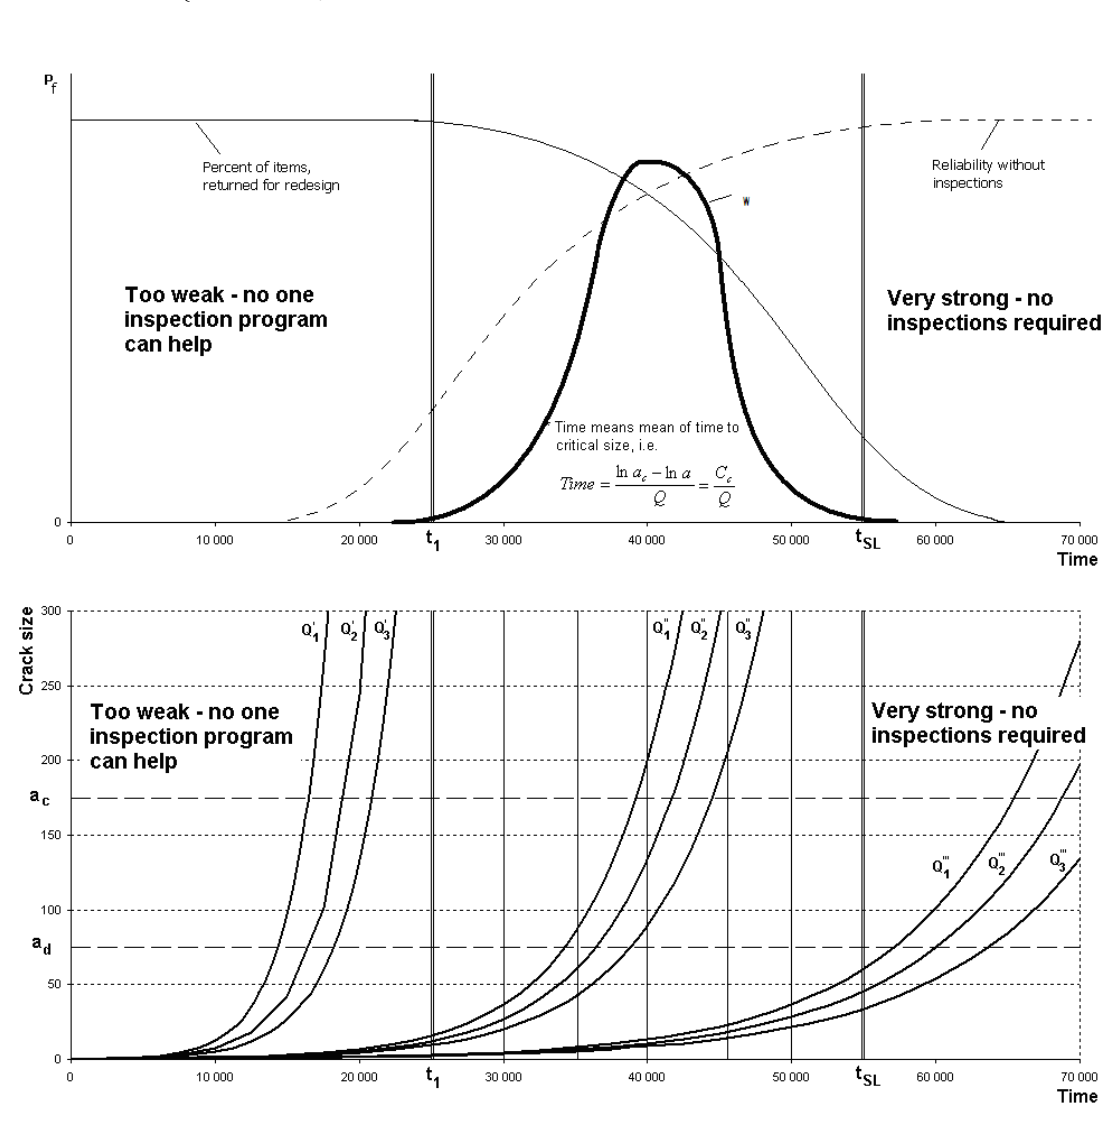
Fig 1. The value of w = as function of for three design versions and corresponding random fatigue crack growth example